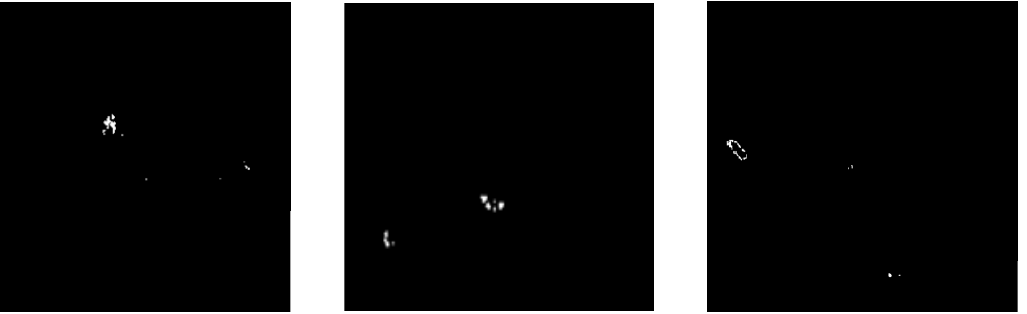
Figure 7. The luminance temperature binarization diagram of 21 channels divided by the OTSU algorithm. The white area of the image is the fire and the black area is the unburned background.